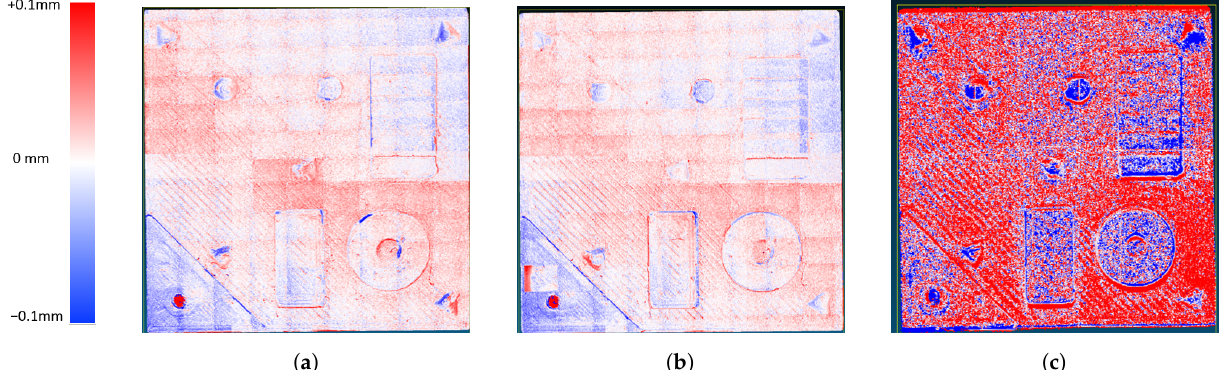
Figure 11. Comparison of the conventional SFF method ( a ), the proposed two-step approach ( b ) and the laser triangulation measurement ( c ) with the reference